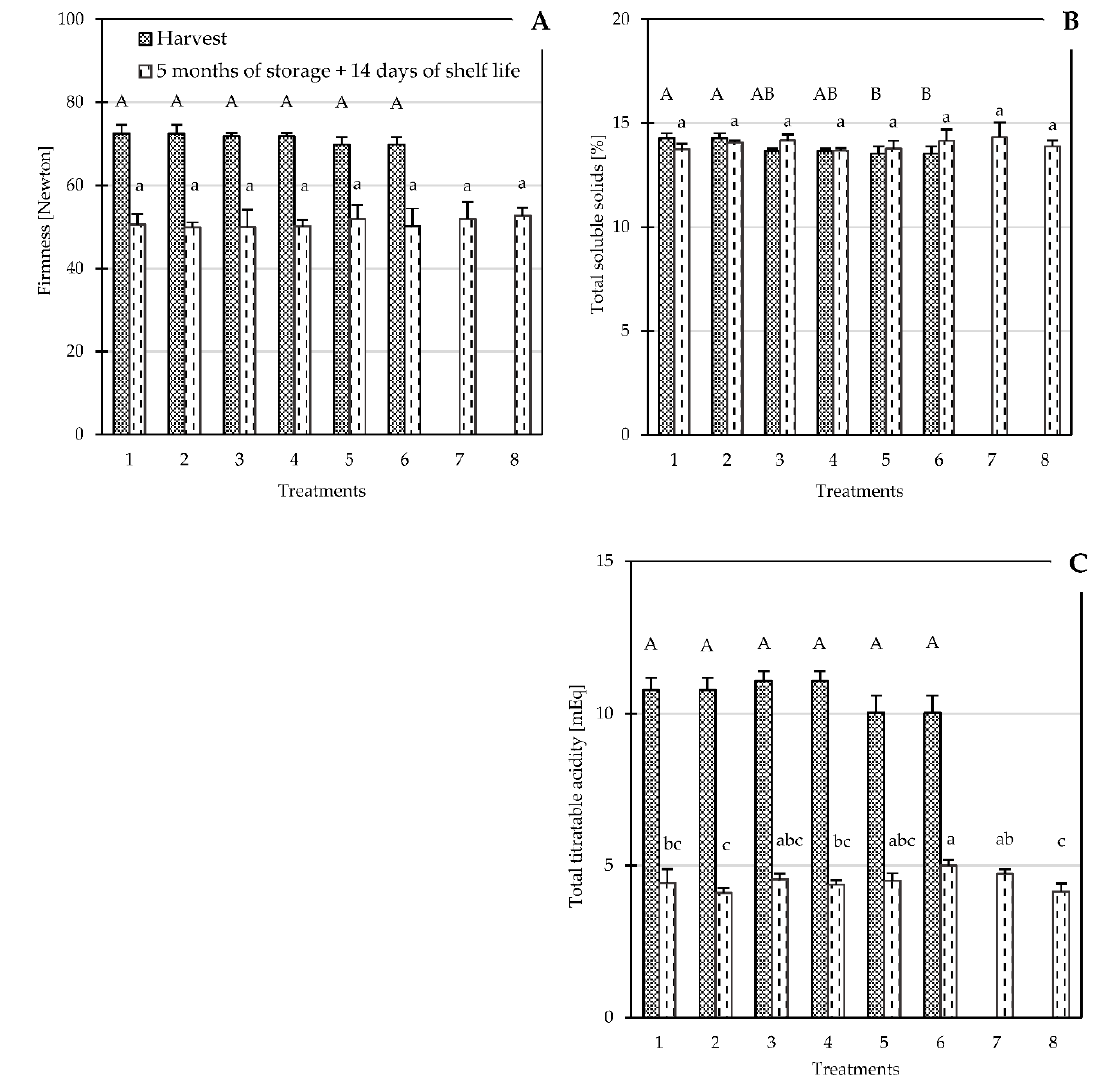
Figure 3. ( A ) Fruit firmness, ( B ) total soluble solids content, and ( C ) titratable acidity at harvest